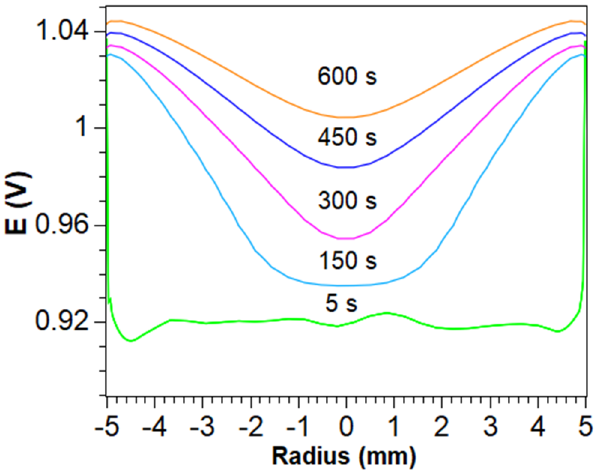
Figure 4. Potential distribution in the Evans’s drop as a function of time over the electrode surface.